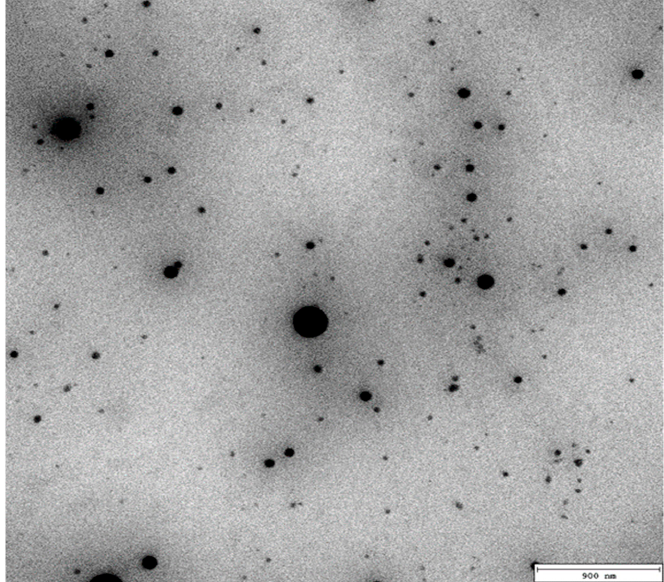
Figure 4. Transmission electron micrograph of peppermint oil nanoemulsion (5% v / v